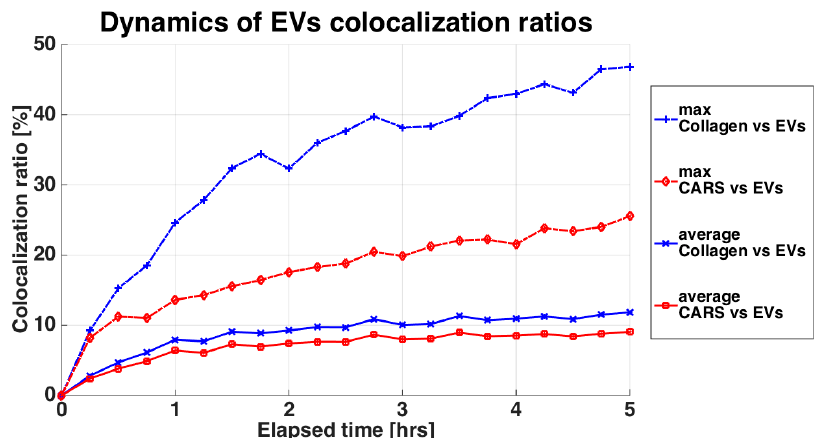
Figure 5. Variation of the co-localization ratios of the EVs with respect to the SHG signal and to the CARS signal. SHG is related to the collagen and thus the extracellular matrix, shown in blue. CARS is related to the lipid cell structures, shown in red. The curves indicate the maximum co-localization value and the average co-localization value computed from the set of Z slices composing the Z-stack for each timeframe.